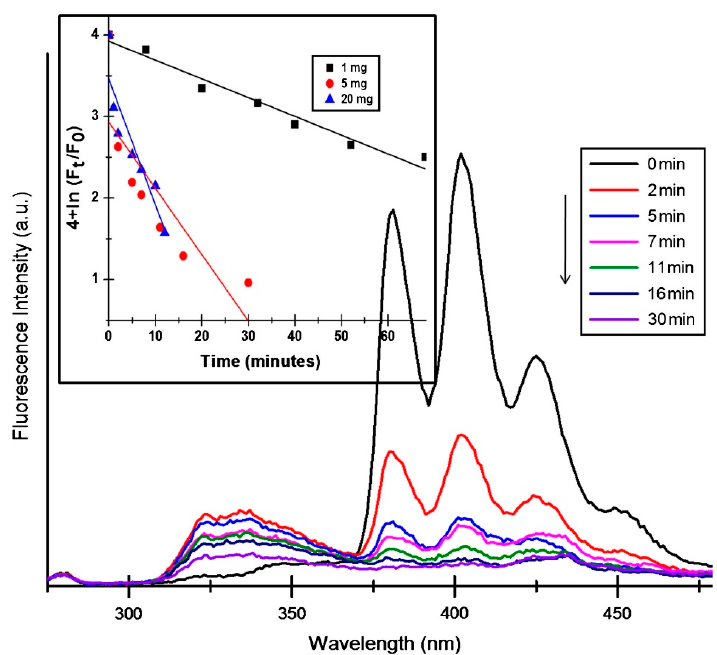
Figure 9. Photocatalytic degradation of anthracene: Fluorescence spectra of 25 ppm anthracene reacted with 5 mg electrospun ZnO nanofibers. The inset shows rate constants for different nanofiber loadings. Reprinted from [14]. Copyright (2013), with permission from Elsevier.